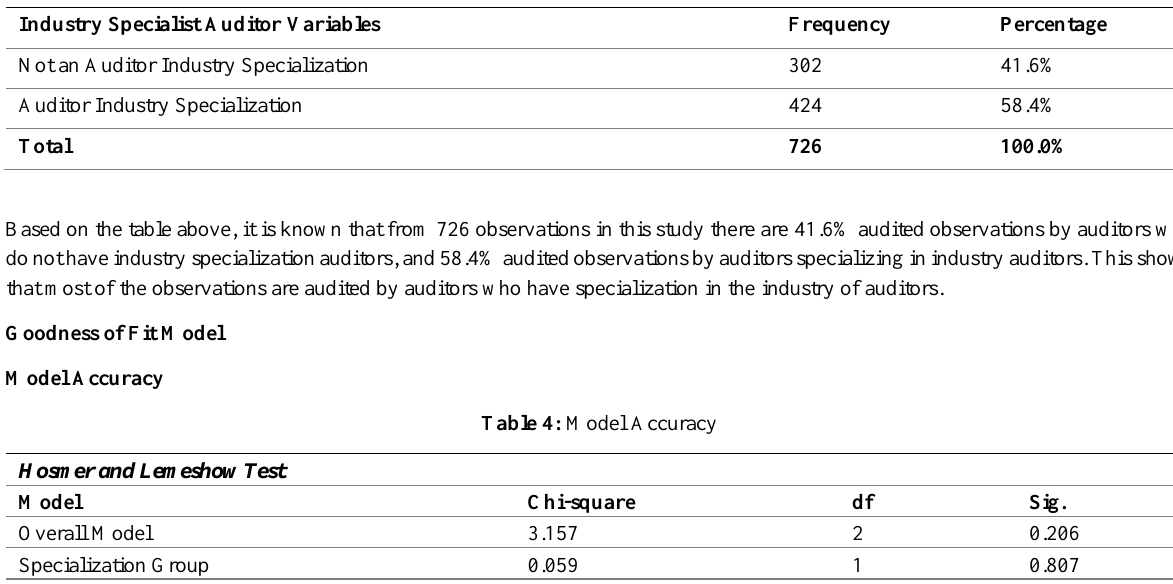
Table 3: Descriptive Analysis of Industry Specialist Auditor Variables